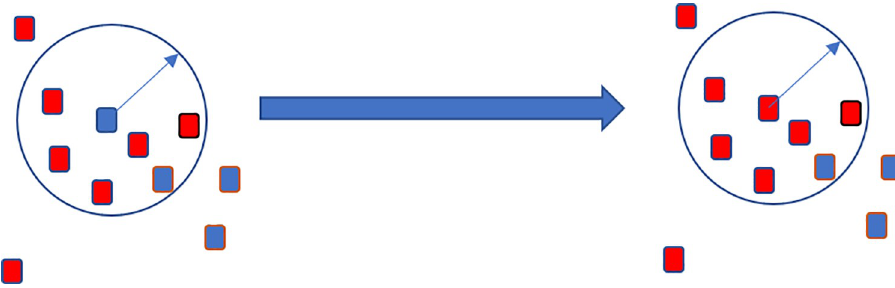
Fig 2. Schematic diagram of label